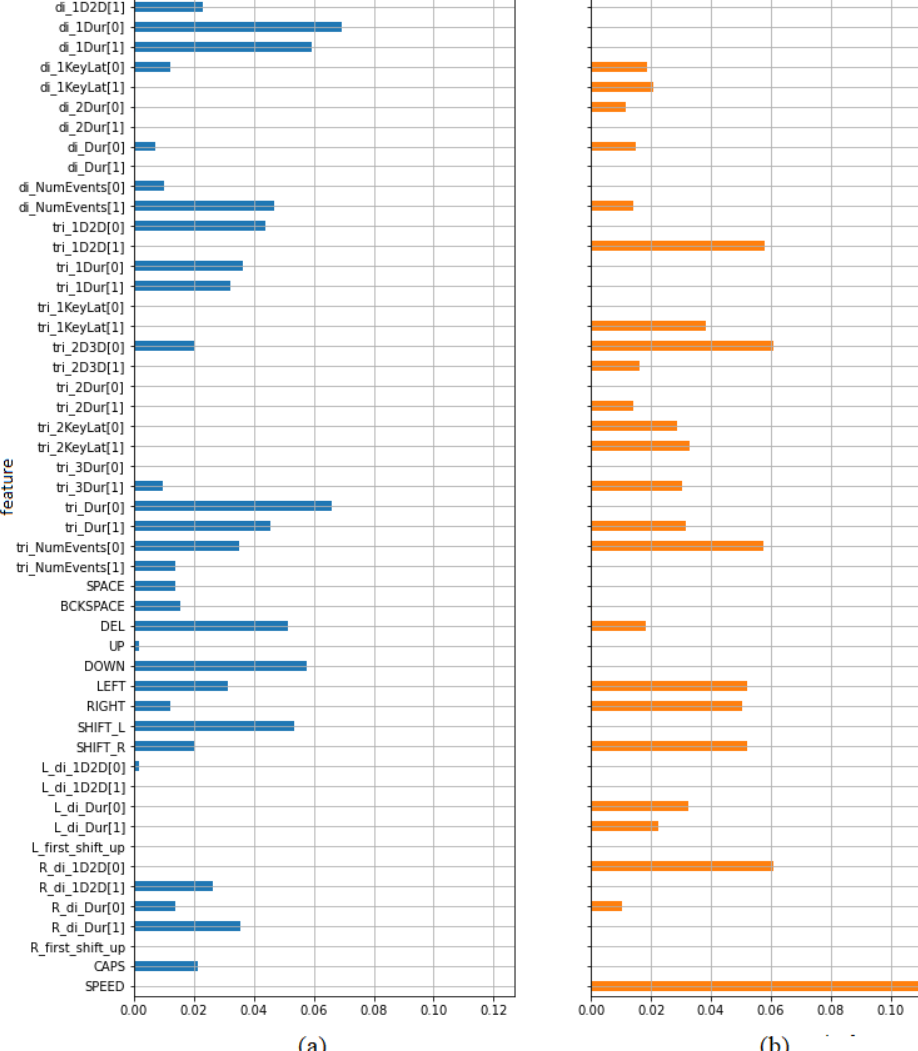
Figure 9. Mutual information values indicating the dependency between features and labels in the task of discriminating between high and low level of ( a ) pleasure, ( b )